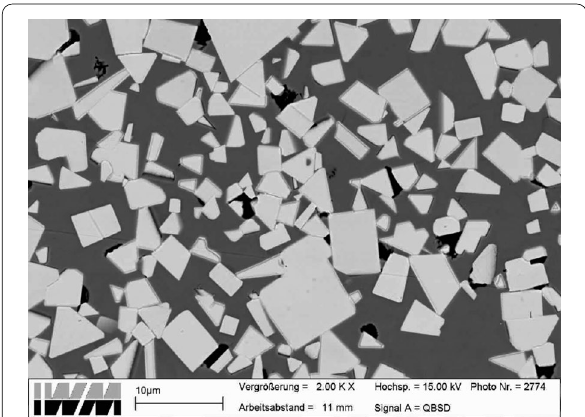
Figure 3 SEM image of the PRMMC material WC- 30 Wt.% Co